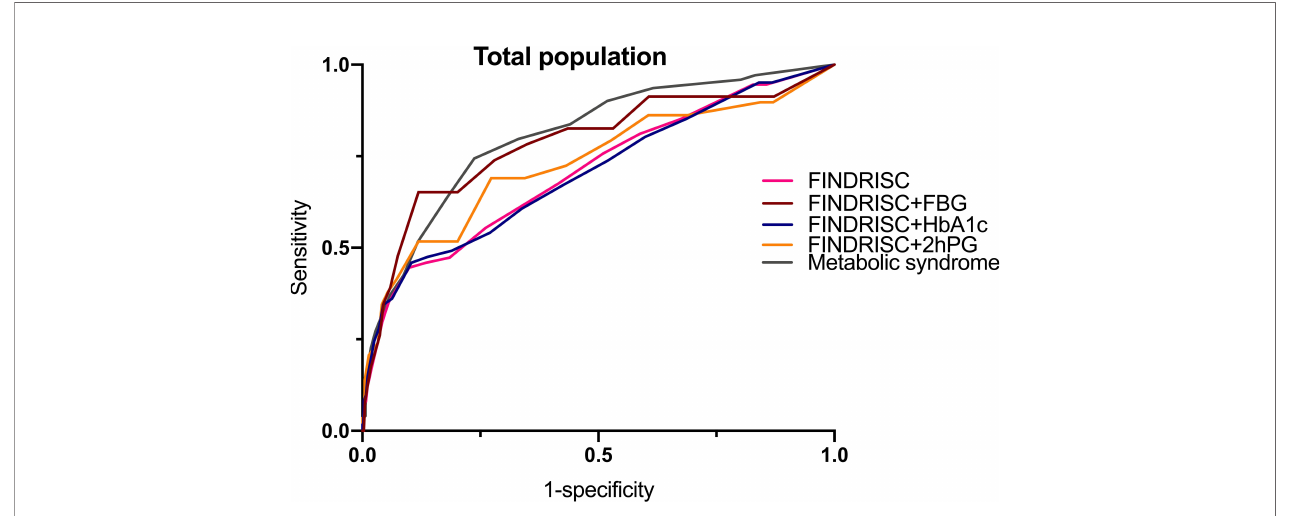
FIGURE 3 | FINDRISC area under ROC curve (AUC) for identifying T2DM in total